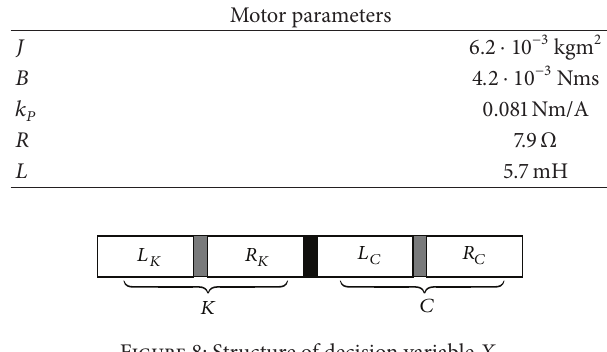
Table 1: Parameters of an electromechanical system.